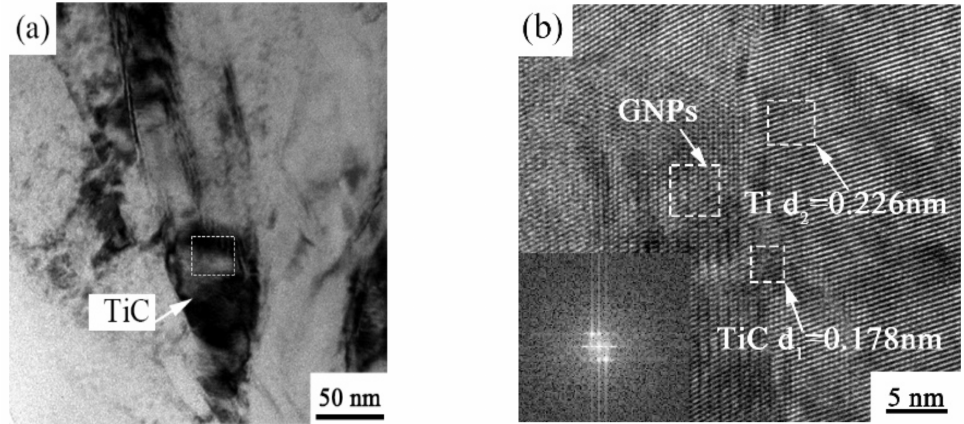
Figure 8. TEM images of GNPs/TC11 composite TiC: ( a ) TEM morphology bright field image of TiC; ( b ) HRTEM image of the enlarged area in ( a